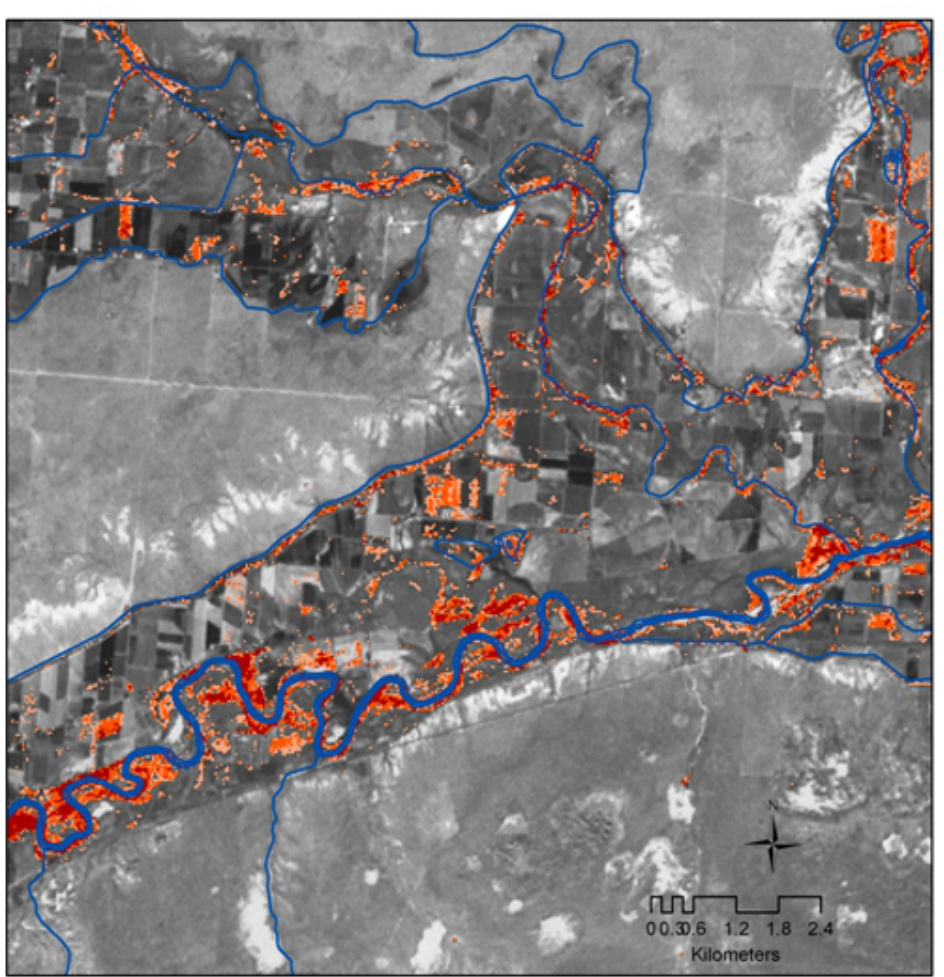
Figure 2. An enlarged view of tamarisk detected along the Arkansas River and irrigation ditches near the town of Riverdale in southeastern Colorado. The results shown here are from a time-series analysis that used 72 remotely sensed data sets from Landsat 7 ETM+. Tamarisk infestations are shown from moderate (orange) to high